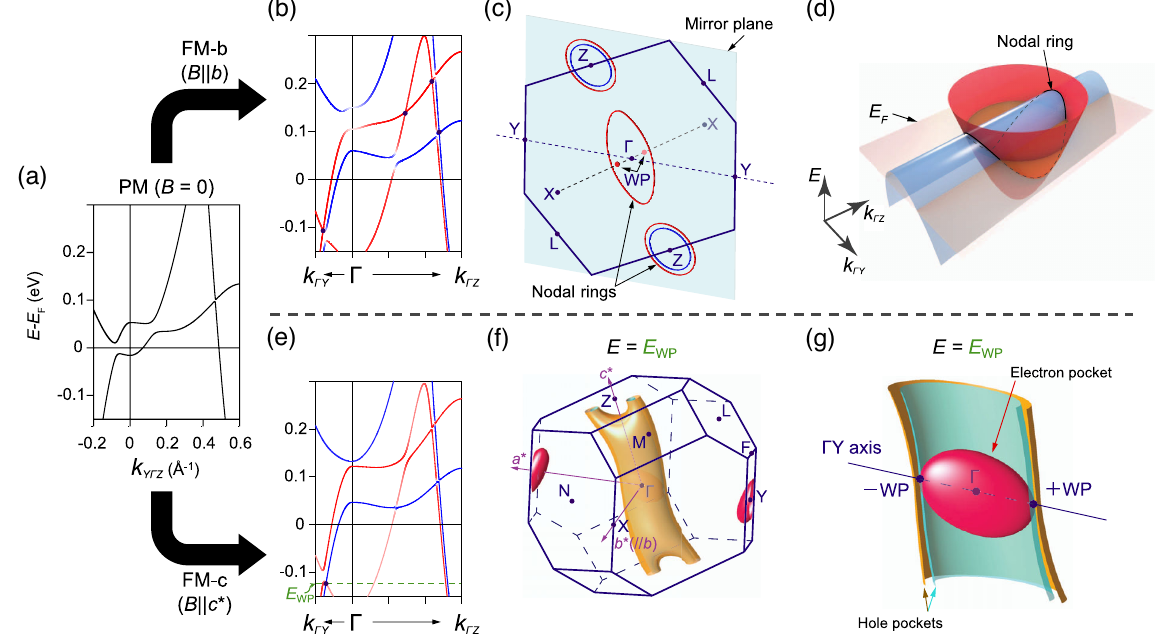
FIG. 4. Electronic structure of α -EuP 3 in the paramagnetic and field-induced ferromagnetic phases in different field directions. Energy dispersions of α -EuP 3 along Y- Γ -Z in the PM phase at (a) B ¼ 0 , and field-induced ferromagnetic phases corresponding to (b) B k b (FM-b) and (e) B k c (cid:2) (FM-c). In panel (e), E denotes the energy level of the Weyl point. The dots in panels (b) and (e) show WP the symmetry-protected band crossings. (c) Schematic illustration of topological nodal lines and Weyl nodes emerging in the vicinity of E in phase FM-b. The nodal rings emerge within the mirror plane and the Weyl nodes along Γ -X (see Supplemental Material [37]). F (d) Schematic illustration of the nodal ring around the Γ point in phase FM-b. The area encompassed by the nodal ring is not flat in energy and spans across E at large M . (f) Brillouin zone and constant energy surface plot at E ¼ E in phase FM-c. The electronic F WP structure is composed of cylinderlike hole pockets stretched along the Γ -Z direction, reflecting the quasi-2D nature of this system, plus small electron pockets centered at the Γ and Y points. (g) Electronic structure around the Γ point at E ¼ E in phase FM-c, showing the WP presence of a single Weyl-node pair along Γ